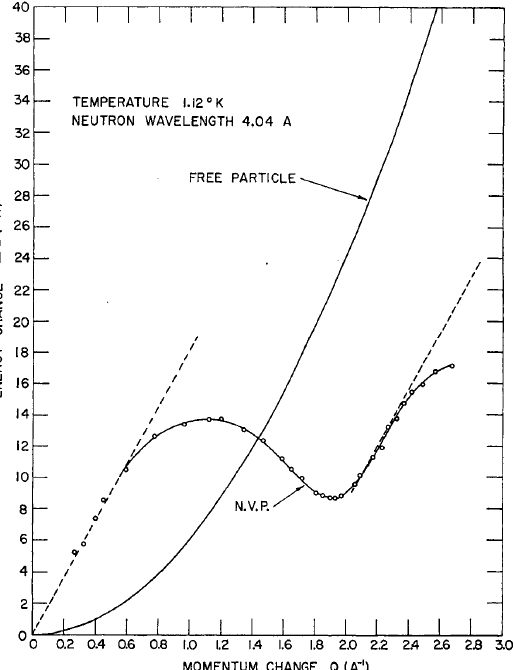
Figure 40. The energy versus wavevector dispersion curve for superfluid liquid helium at 1.12 ◦ K at its normal vapor pressure. The parabolic curve rising from the origin represents the calculated dispersion for free helium atoms at absolute zero. The circles correspond to the energy and wavevector of the measured excitations, and a smooth curve has been drawn through the points. The broken curve rising linearly from the origin is the theoretical phonon branch calculated with a velocity of sound of 237msec − 1 . The dotted curve drawn through the point at Q = 2.27Å − 1 has been drawn with a slope equal to the velocity of sound. This figure is taken from Figure 4 of ref. [100]. Copyright by the American Physical Society.